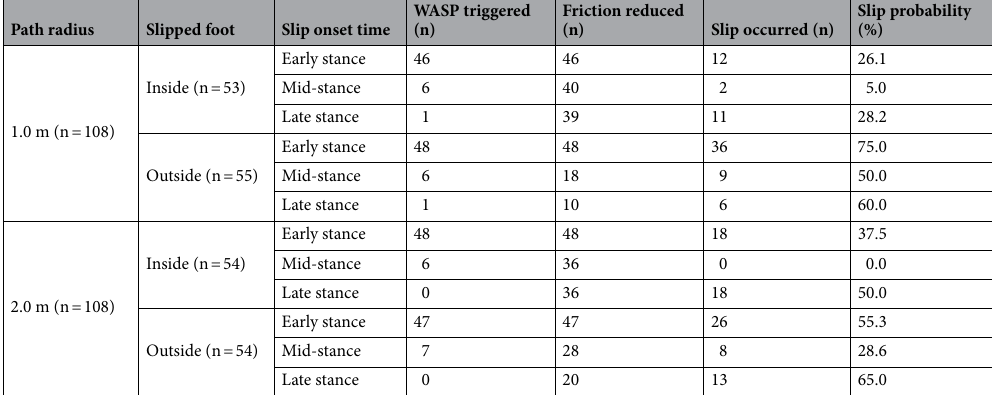
Table 1. Descriptive details about the slip perturbations delivered in this study. WASP trigger phases were calculated as the time between WASP triggering and heel strike of the targeted stance phase divided by the mean stance duration within a given condition set, then binned into early, mid-, and late stance phases (WASP Triggered). “WASP Triggered” values here are trial counts within each phase bin. The number of trials within each condition set where friction was reduced prior to a slip occurring is given in the “Friction Reduced” column. Note that these are cumulative counts including trials where friction was reduced by WASP triggering at an earlier stance phase than when a slip actually occurred. For example, a trial where WASP was triggered during early stance but the resulting slip occurred during late stance would be counted in early, mid-, and late stance bins under “Friction Reduced”. Slip onset phases were calculated as the time between slip onset and heel strike of the targeted stance phase divided by the mean stance duration of that condition set and binned into the three stance phases, presented here as trial counts within each bin (Slip Occurred). These three columns are ordered temporally: WASP triggering occurs first, causing friction reduction underfoot that potentially, whether within the same or later phase of stance, results in a slip. Finally, “Slip Probability” was calculated by dividing the “Slip Occurred” value by the “Friction Reduced” value for a given condition set, returning the likelihood that a slip would occur if friction was reduced under those